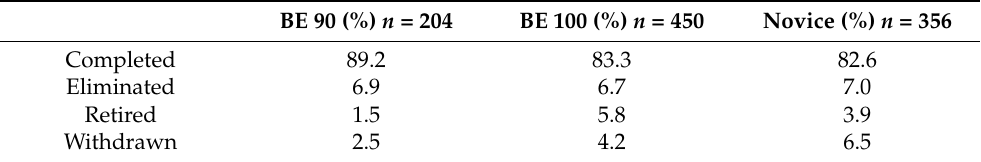
Table 5. The proportions of completions, eliminations in any phase, retirements (in showjumping or cross-country) and withdrawals (before show jumping or cross-country), expressed as percentages of competition starts ( n = 1010) for horses competing at British Eventing 90, 100 or Novice levels.